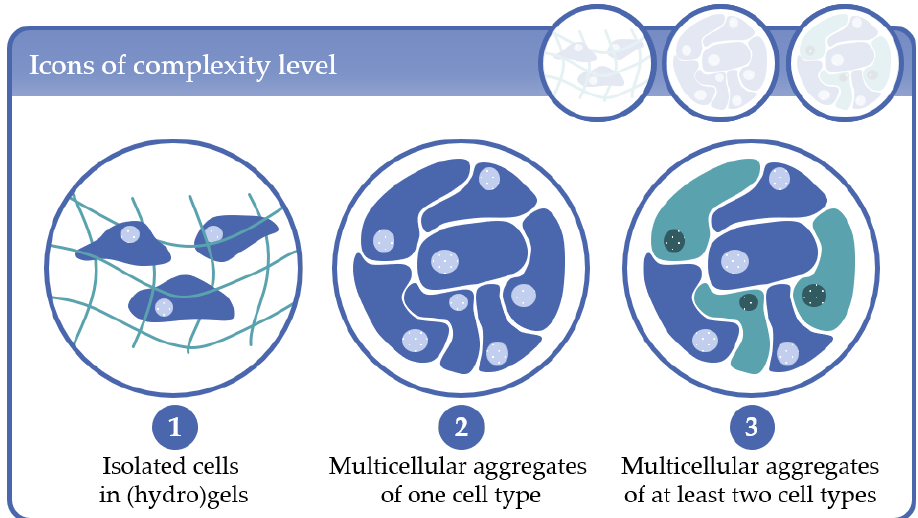
Figure 1. For a better overview of the discussed micro-bioreactors (MBR) systems and the corresponding complexity levels the depicted icons are given in the particular sections.